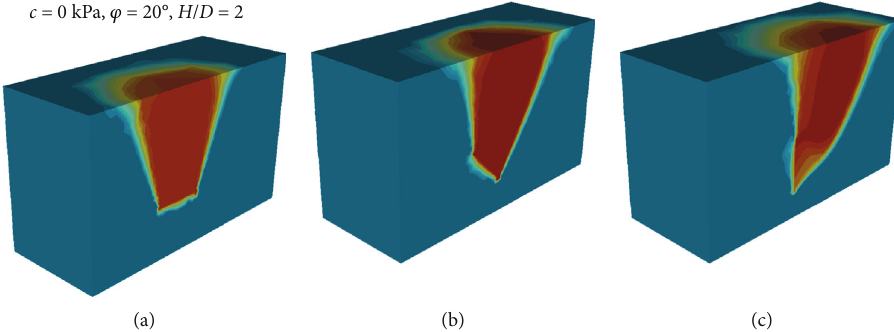
Figure 10: 3D-Failure of circular anchor plate at (a) θ = 0 ° , (b) θ = 45 ° , and (c) θ = 90 ° for c = 0kPa .